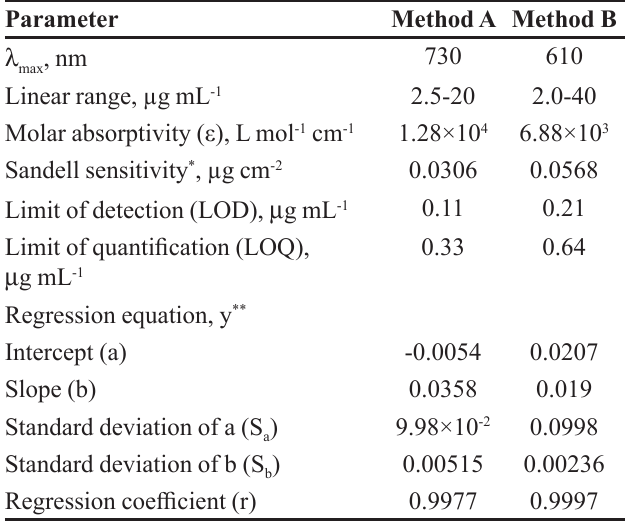
TABLE I - Sensitivity and regression parameters